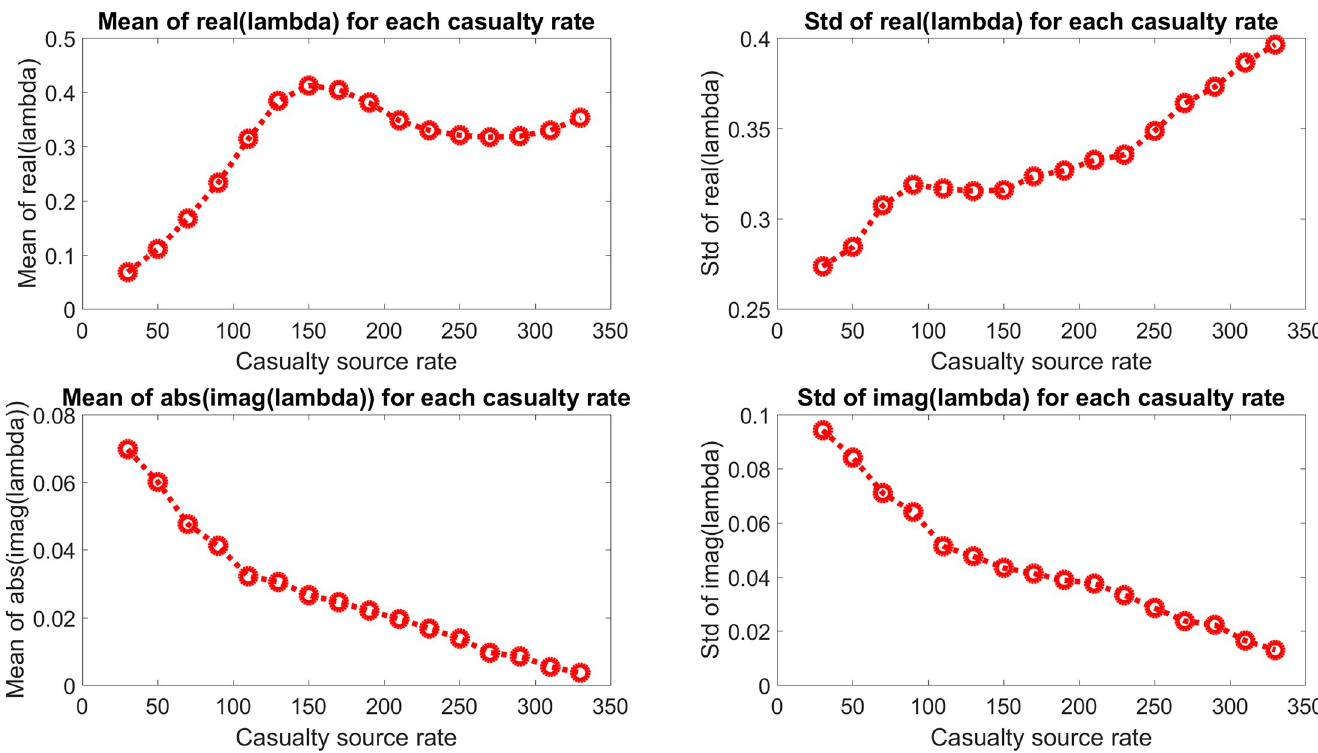
Fig 6. Mean and standard deviation of the real and imaginary components of the eigenvalues in Fig 5. The real components are seen to increase with casualty source rate and approach an approximate maximum, and the imaginary components are seen to approach the real axis.